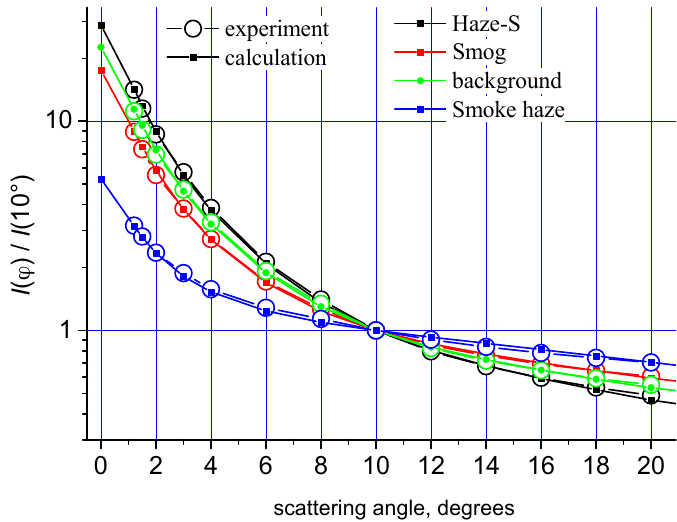
Figure 2. An example of “fitting” the angular scattering coefficients calculated using the Mie formulas to the measured values in different types of aerosol weather for summer. Differences in the shape of the aerosol particle size distribution function before and after correction in the size range of coarse particles using the data on the angular scattering coefficients in the range = 1.2° to 20° are shown in Figure 3.